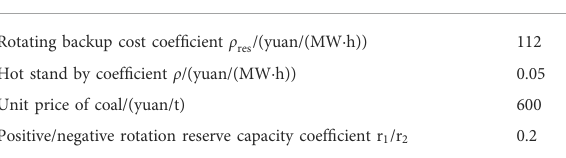
TABLE 1 Main parameters of the lower-layer model.